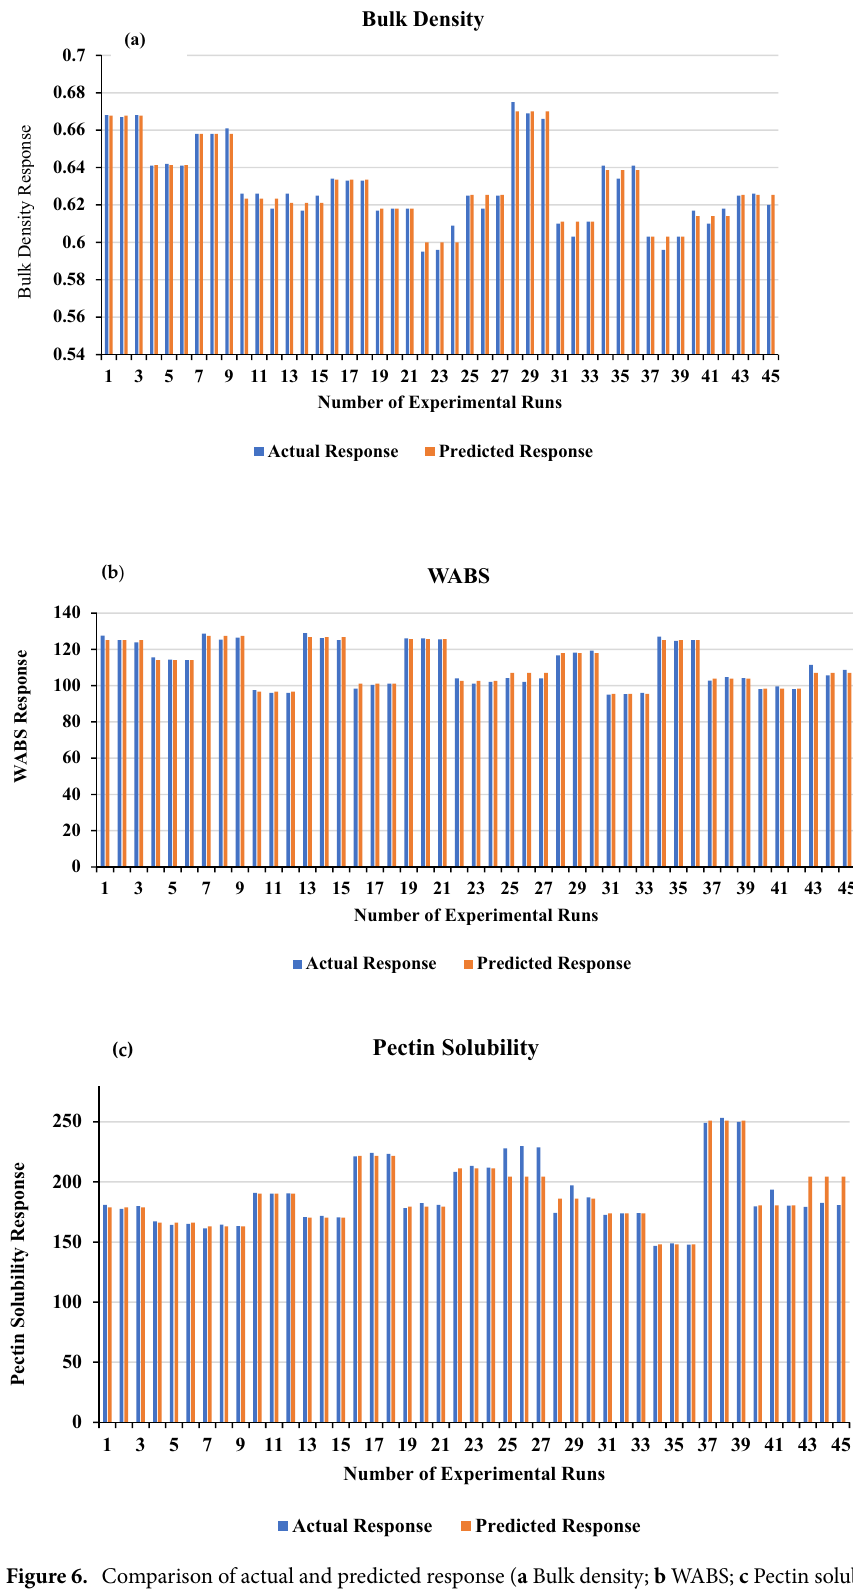
Figure 6. Comparison of actual and predicted response ( a Bulk density; b WABS; c Pectin